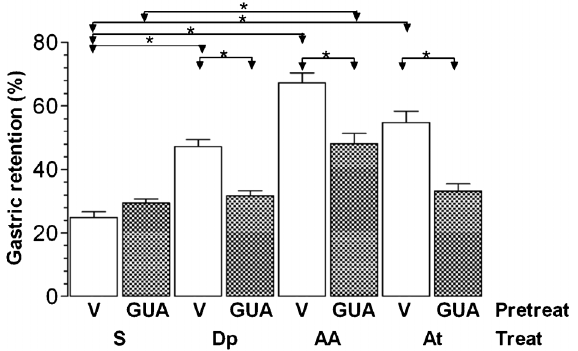
Figure 2. Gastric retention (%) of a saline test meal 10 min after administration to rats by gavage. The animals were pretreated (Pretreat) iv with saline as a vehicle (V) or with 4 mg/kg propranolol (PRO), 15 min before the iv treatments (Treat) with saline (S) or 240 m mol/kg dipyrone (Dp), 4-aminoantipyrine (AA) or antipyrine (At). The test meal was administered 10 min after the treatment. Data are reported as means±SE for 8 animals per group. *P , 0.05 (Tukey